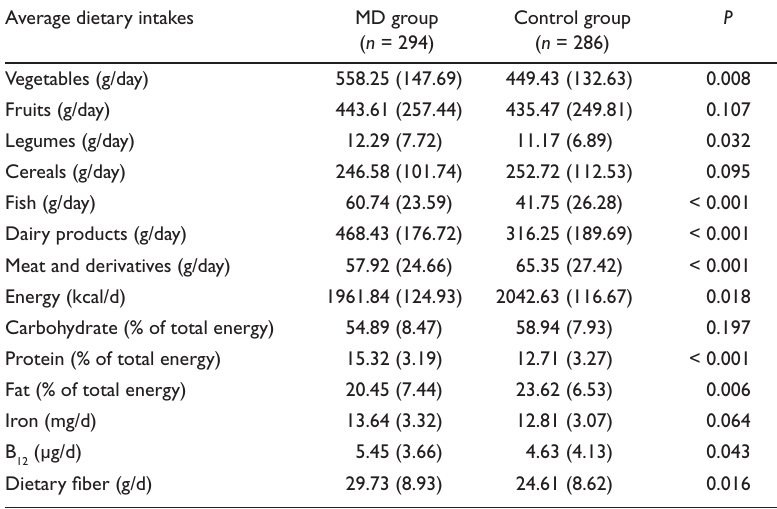
Table 2. Dietary intakes of participants Average dietary intakes